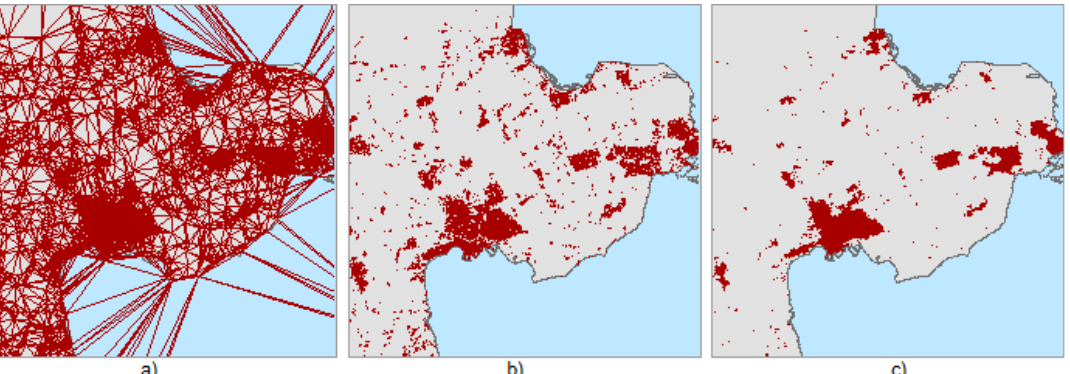
Figure 2. Generating natural cities from road intersections. Panel ( a ) shows the constructed TIN lines connecting each intersection to each other based on proximity. Panel ( b ) shows the same dataset, however the longer distances determined by head/tail breaks have been removed. The final panel ( c ) shows the natural cities derived from the input OSM roads [23].